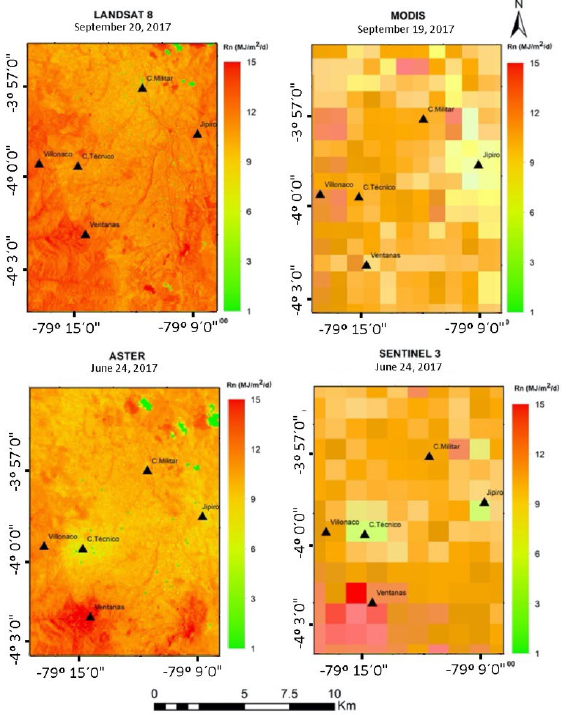
− 2 day − 1 ) for the different